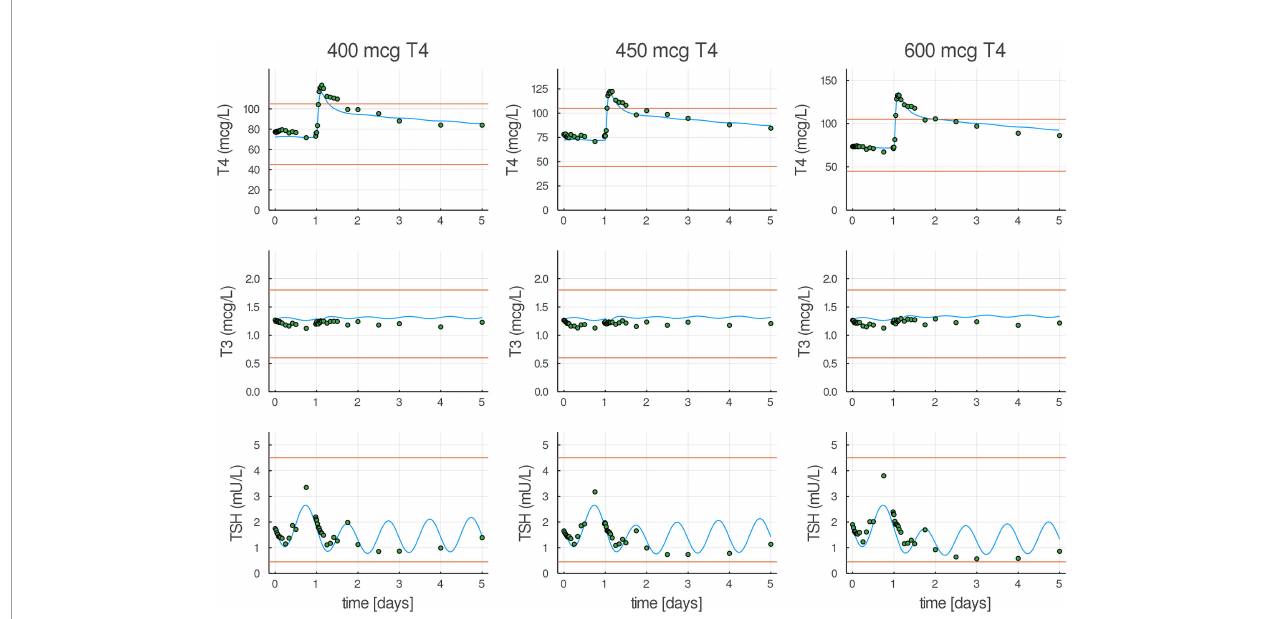
FIGURE 4 | Model predictions compared to T4, T3, and TSH experimental euthyroid data. T4, T3, and TSH responses in healthy volunteers to three different oral doses (400, 450, and 600 µg) of LT4 (21), shown as dots, compared with our fi tted model (blue curves). Normal ranges are shown as red